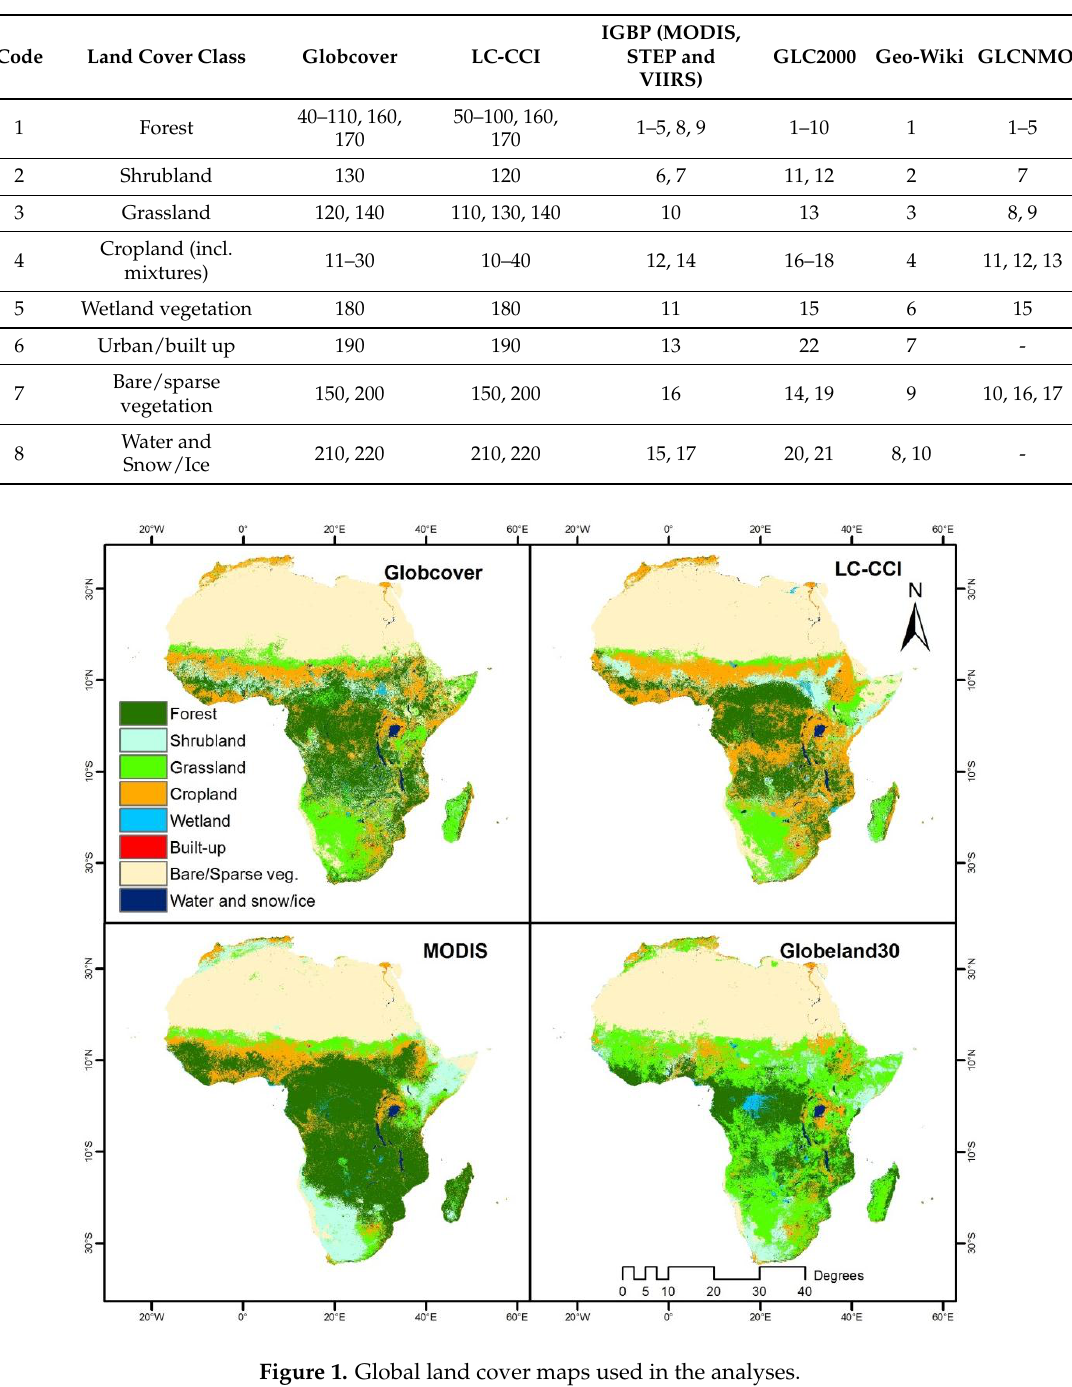
Table 2. General land cover classes and corresponding classes of the GLC datasets.